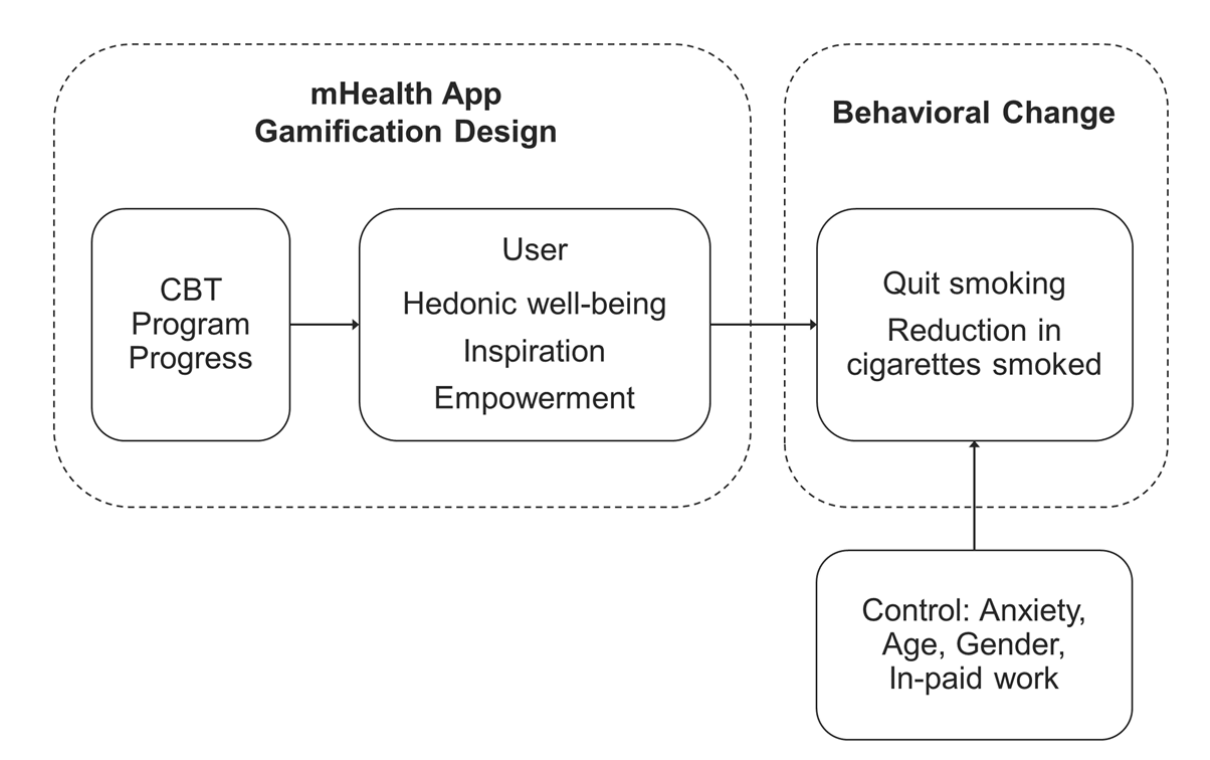
Figure 1. Research model. CBT: cognitive behavioral therapy; mHealth: mobile